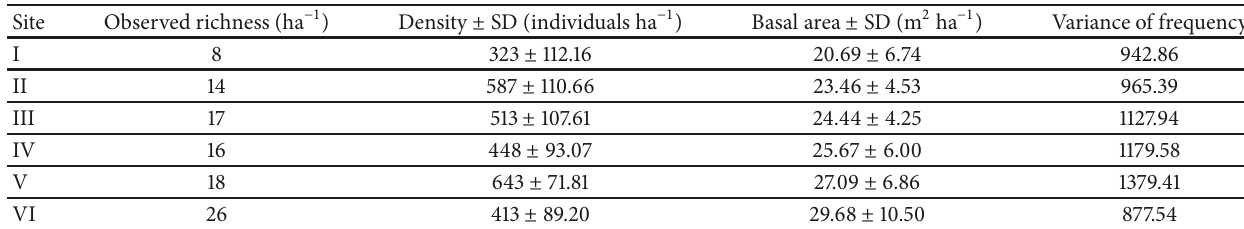
Table 5: Observed richness, total density, and total basal area along the sites of Radha Krishna BZCF. Site Observed richness (ha −1 ) Density ± SD (individuals ha −1 ) Basal area ± SD (m 2 ha −1